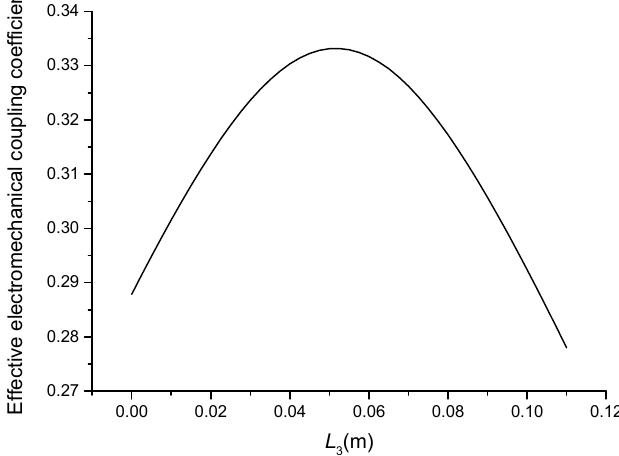
Figure 7. Theoretical relationships between the resonance/anti-resonance frequencies and length L 3 at the fundamental mode (Position effect of PZT-2).